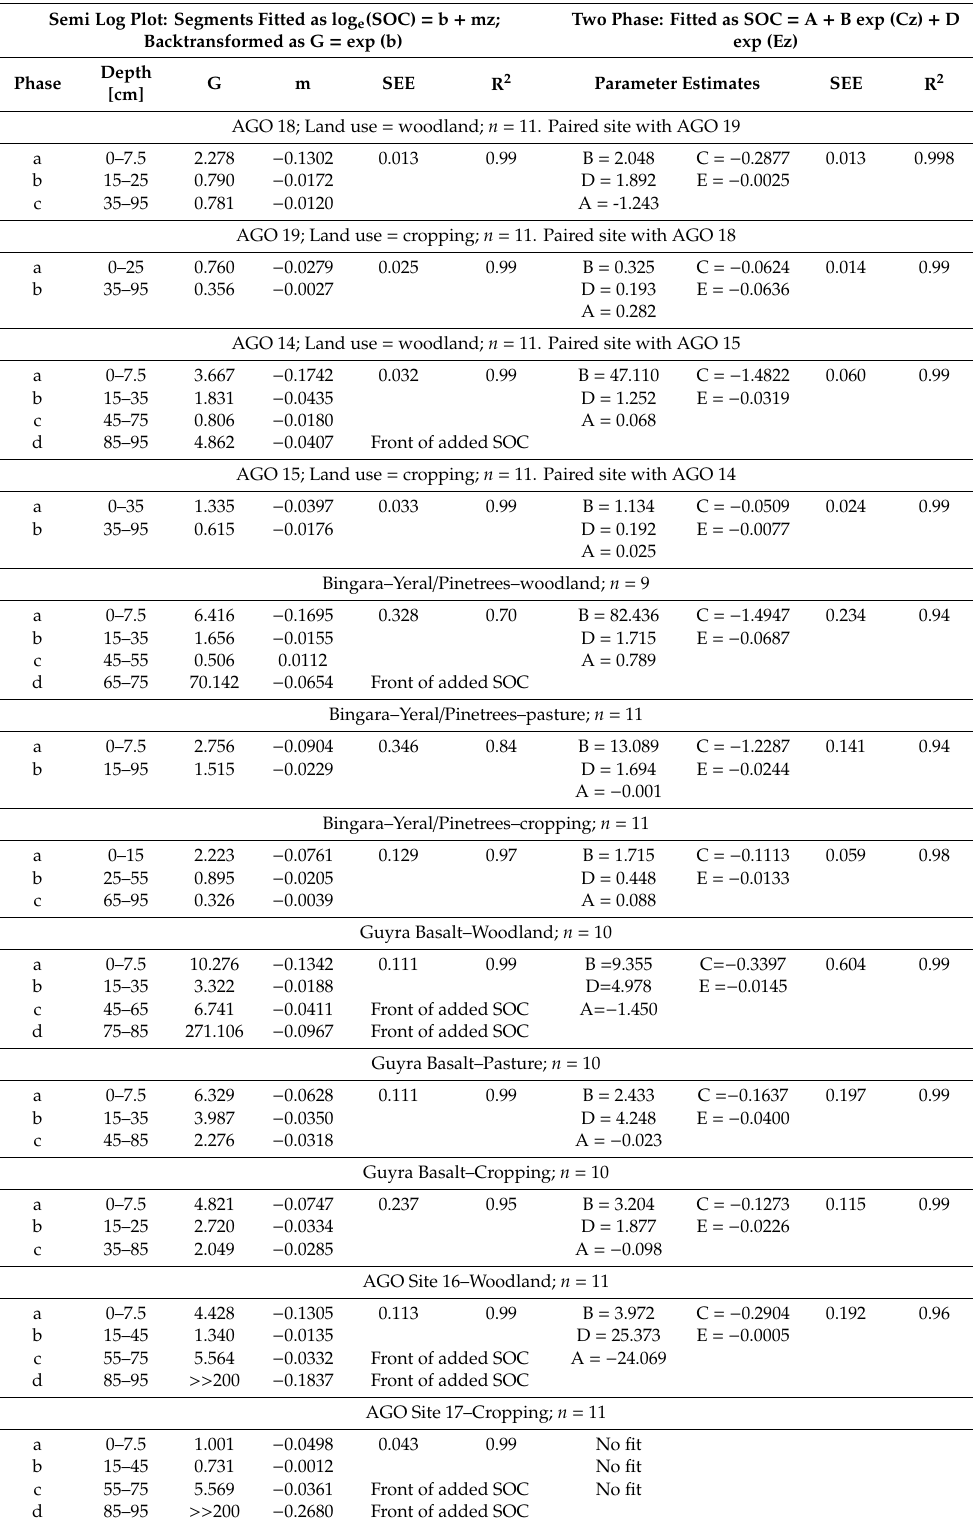
Table 5. Relationships based on semi-log plots and two-phase exponential functions for several SOC profiles with di ff erent paired land